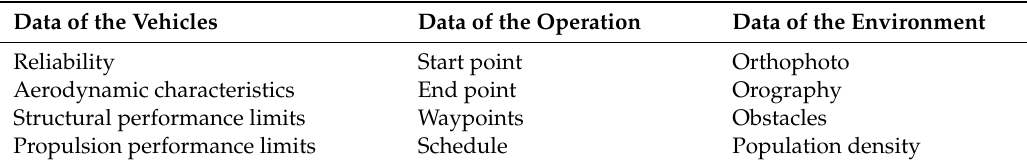
Table 1. Flight planner (FLIP) input